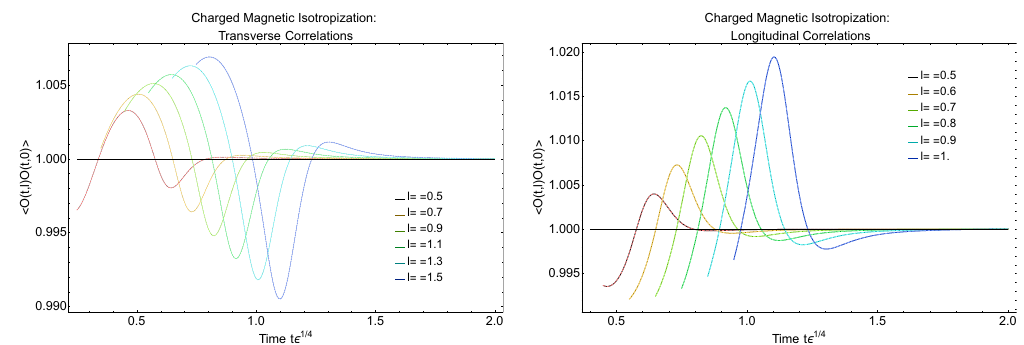
Figure 24 . 2-point correlation functions of an (uncharged) scalar operator in charged thermalizing (cid:13)uid (dual to the evolution towards a magnetic black brane geometry), (cid:26) = : 001, B = : 0085. Left: various length separations in the transverse direction. Right: various length separations in the longitudinal direction. The purely anisotropic case (a) is shown for comparison as dashed curves.